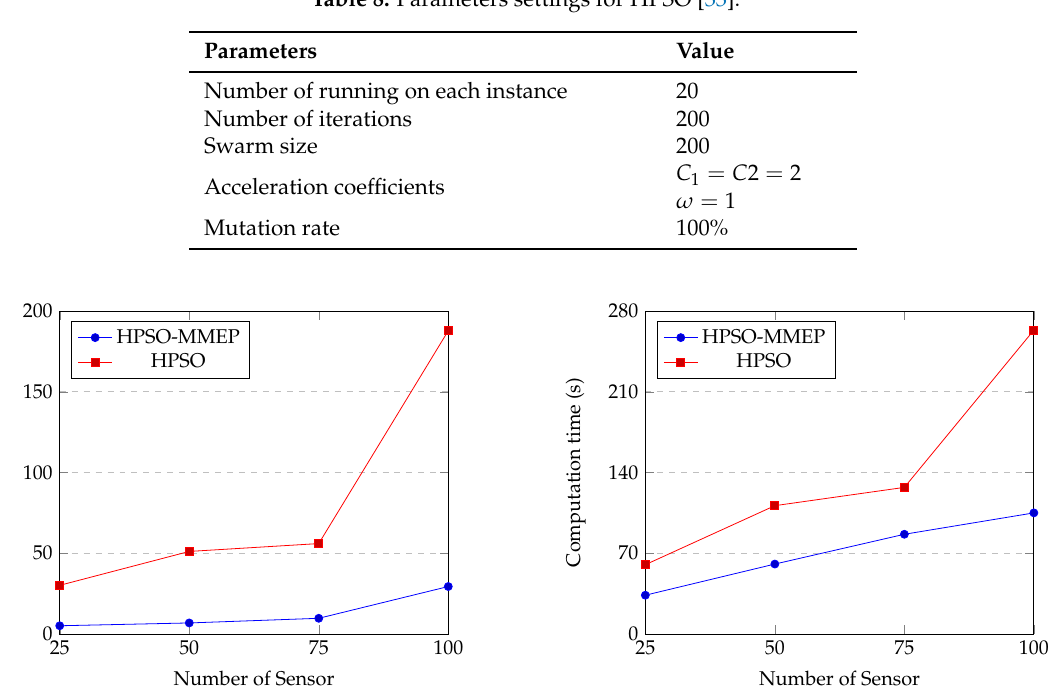
Table 8. Parameters settings for HPSO [33].